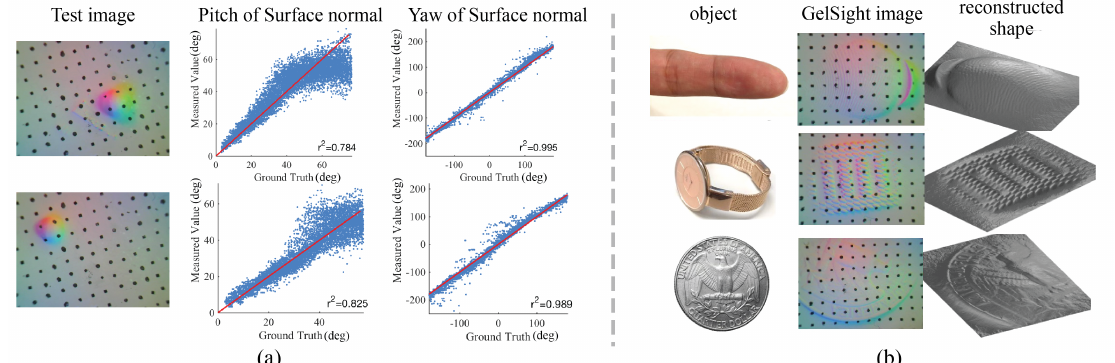
Figure 13. Evaluation on the shape measurement of fingertip GelSight (Figures adapted from [29] (©2017 IEEE)). ( a ) the measurement of surface normal, when there the sensor is contacting a small ball. The plots compare the measured surface normal value and the ground truth, where the red line marks equal relation. The pitch can be considered as the magnitude of geometry gradient of the contact surface, and the yaw can be considered as the planar direction of the gradient; ( b ) examples of reconstructed 3D geometry when contacting different